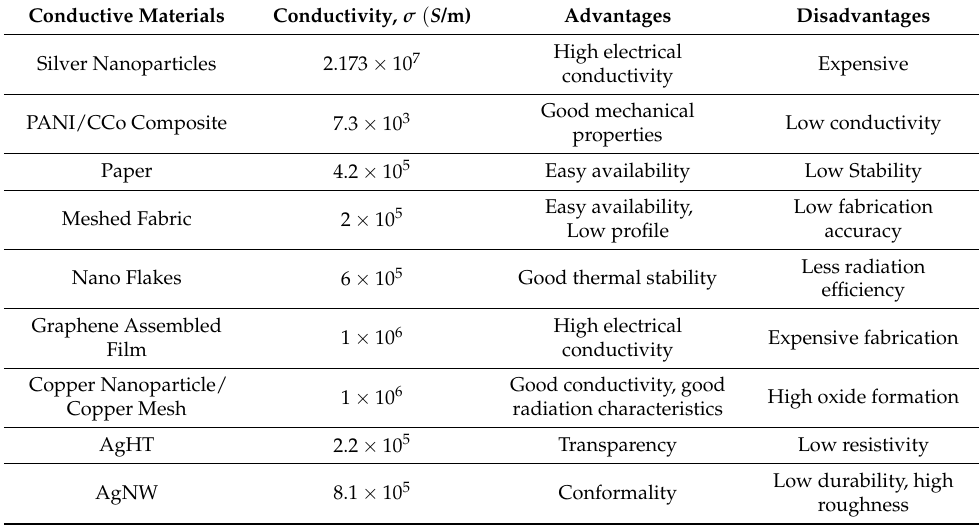
Table 2. Conductive materials for a flexible antenna. Reprinted from refs.